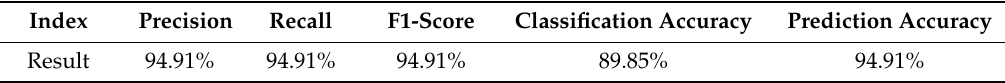
Table 4. Classification and prediction accuracy for collective samples.